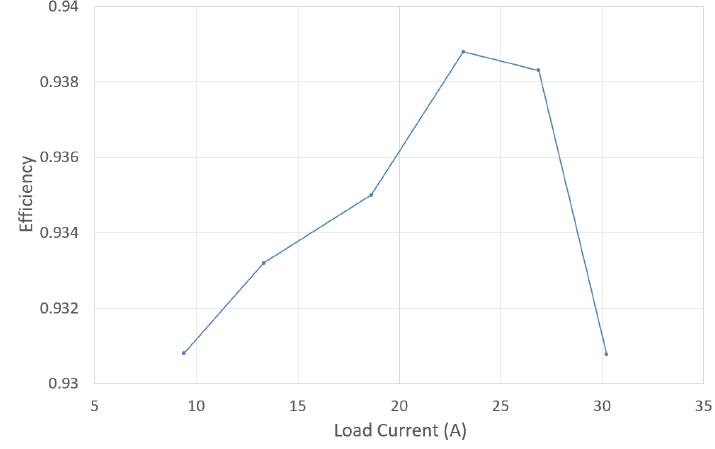
Figure A3. The efficiency of the DC-DC convertor under different load current.